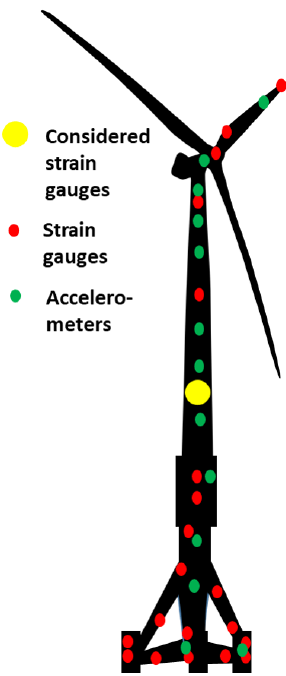
Figure 3. Illustration of the AV-07 turbine (not to scale) and some of the installed sensors according to the sensor documentation (IWES,